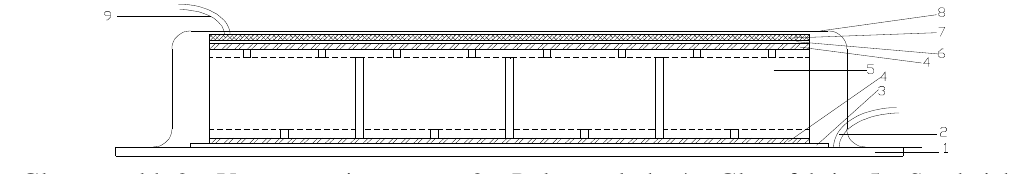
Figure 1. Experimental device schemes of the vacuum assisted resin infusion molding process